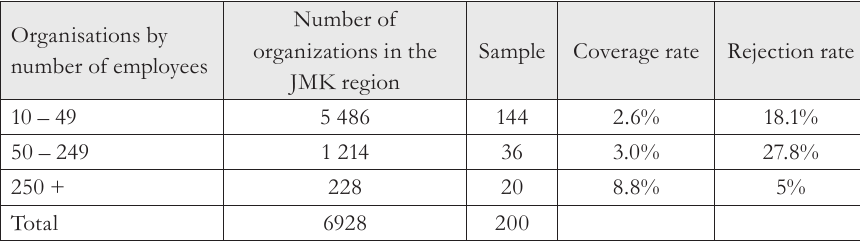
Tab. 2 - The Structure of the Sample. Source: own